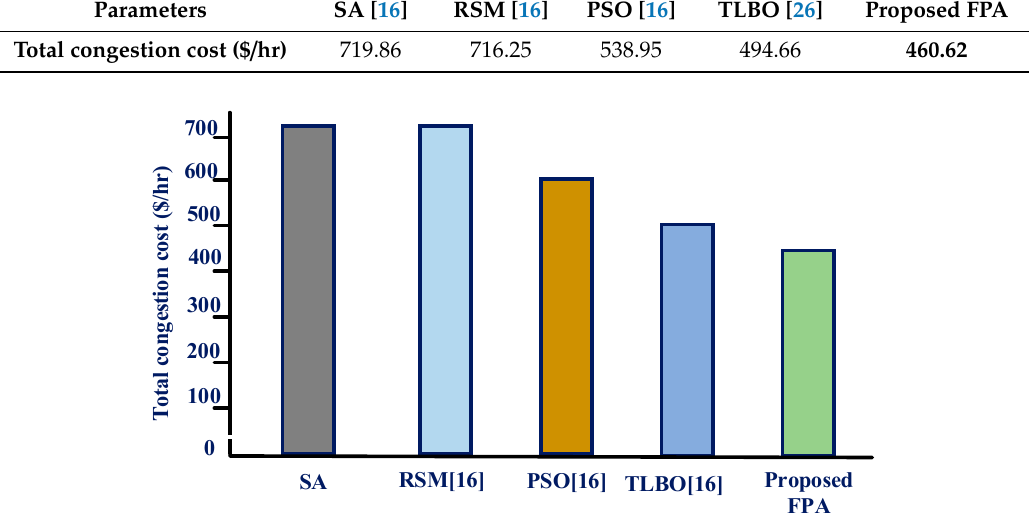
Table 5. Validation of proposed FPA with other optimization techniques.